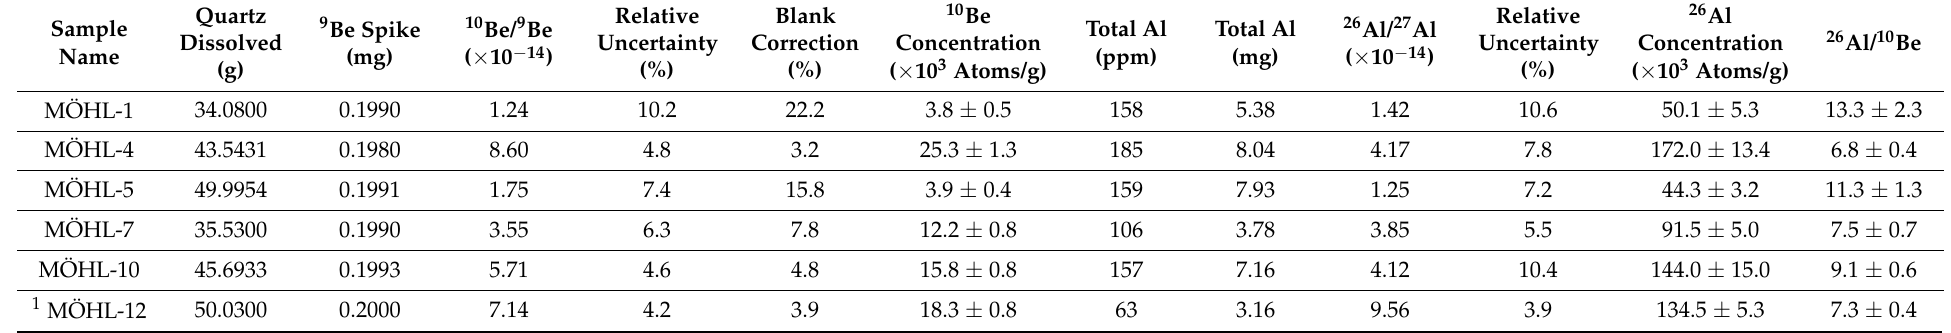
Table 2. Cosmogenic 10 Be and 26 Al results of the samples from the Möhlin